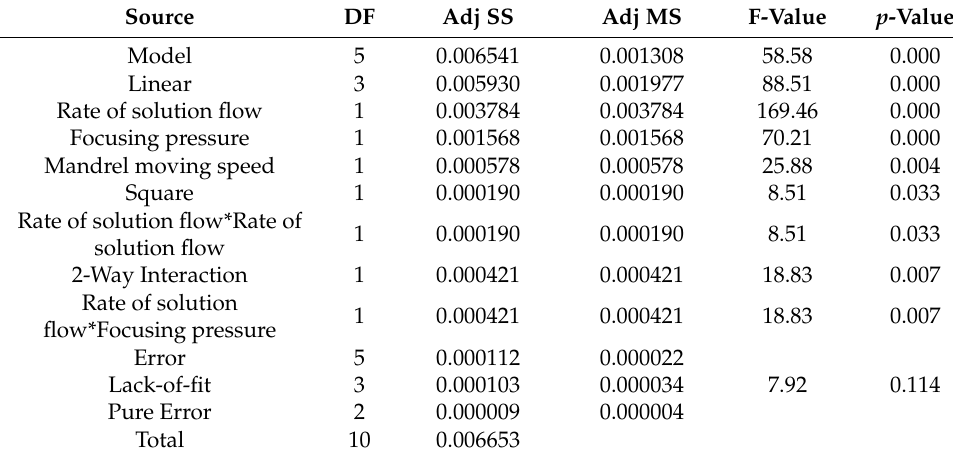
Table 1. Analysis of Variance.